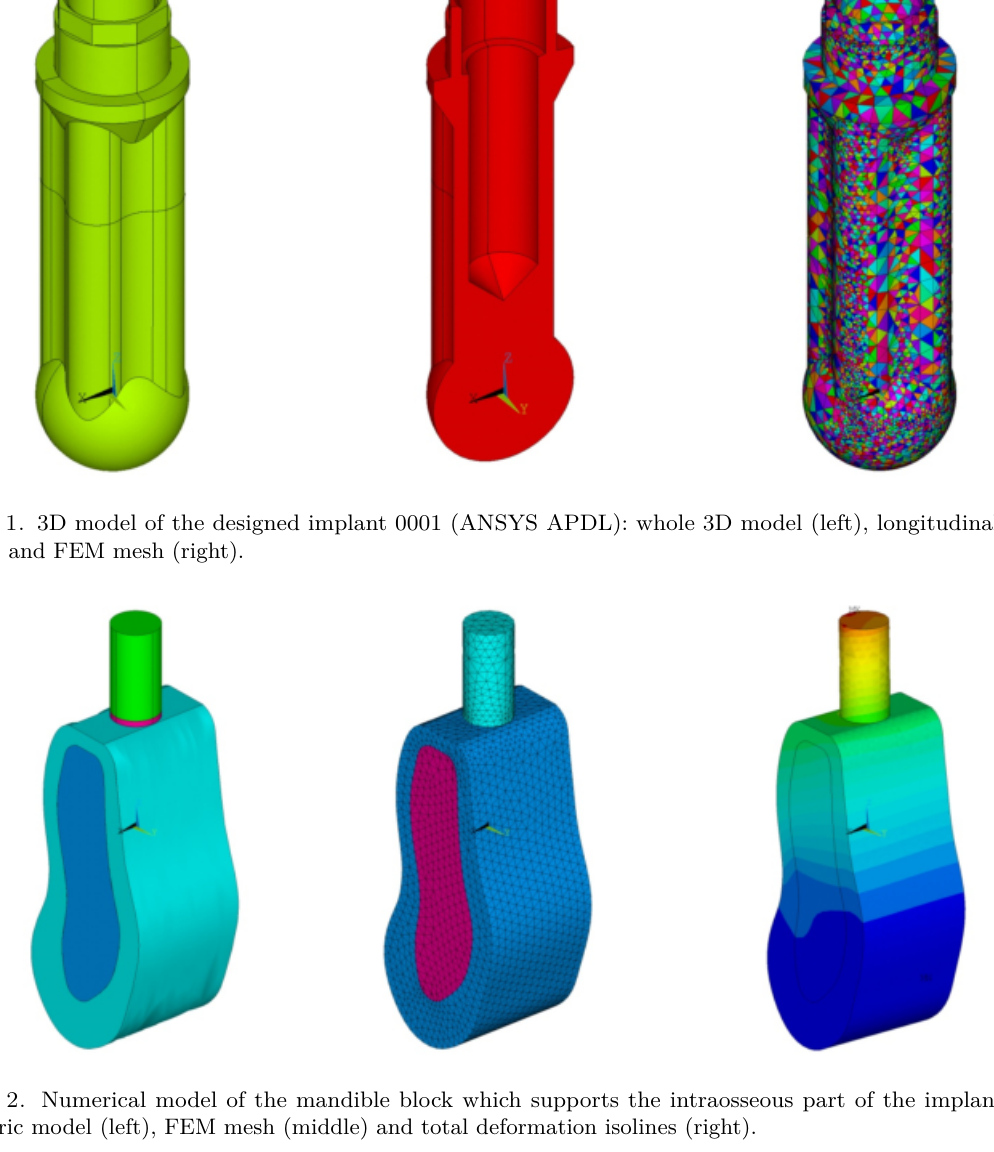
= 25 µ m (left), equivalent max = 91.7 MPa (middle and eqv,max